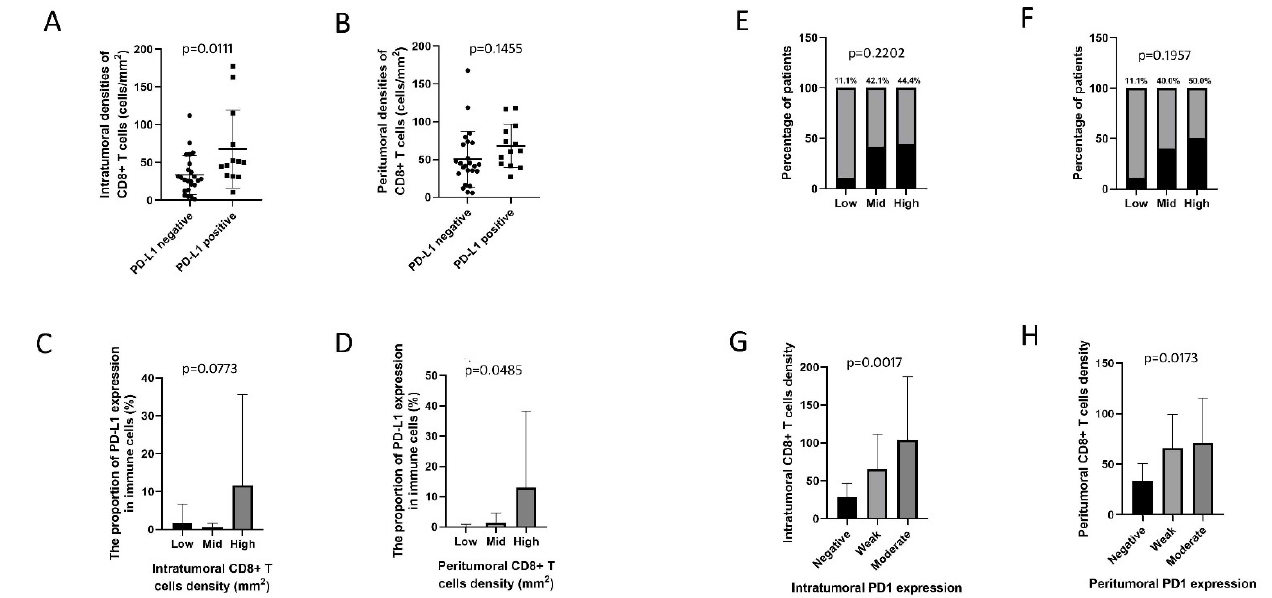
Figure 2. The association between PD-L1 expression and CD8+ T cell density. ( A ) The association between PD-L1 expression and intratumoral CD8+ T cell density. ( B ) The association between PD-L1 expression and peritumoral CD8+ T cell density. ( C ) The association between the percentage of PD-L1 expression and intratumoral CD8+ T cell density as levels by quartiles. ( D ) The association between the percentage of PD-L1 expression and peritumoral CD8+ T cell density as levels by quartiles. ( E ) The association between the percentage of patients with PD-L1 expression and intratumoral CD8+ T cell density as levels by quartiles. ( F ) The association between the percentage of patients with PD-L1 expression and peritumoral CD8+ T cell density as levels by quartiles. ( G ) The association between intensity score of intratumoral PD1 expression and intratumoral CD8+ T cell density as levels by quartiles. ( H ) The association between intensity score of peritumoral PD1 expression and peritumoral CD8+ T cell density as levels by quartiles.